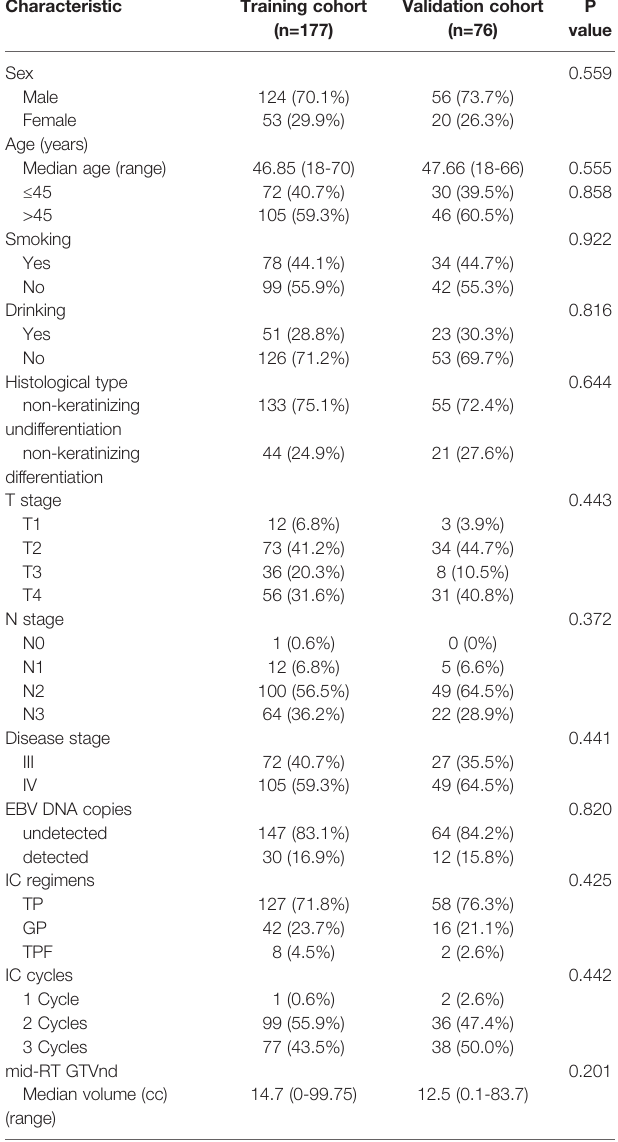
TABLE 2 | Characteristics of Patients in the Primary and Validation